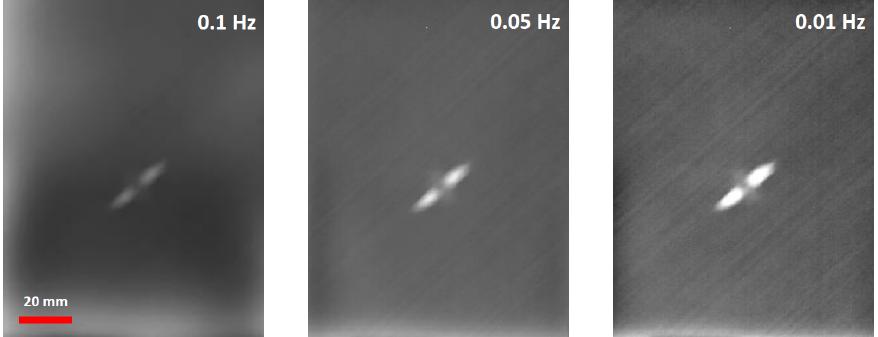
Figure 4. Selection of optimal frequency f i in thin (9-layer) composite laminates with an impact energy of 8 Joule, under PP configuration, based on optimal contrast of phase-domain thermograms.